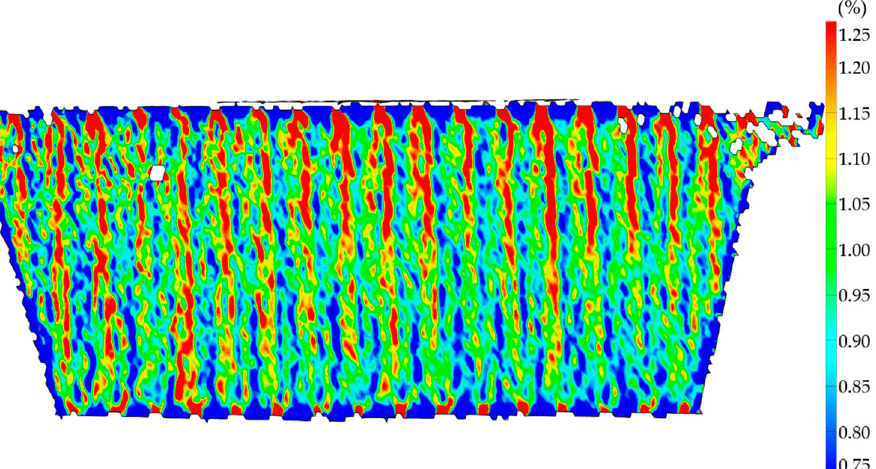
Figure 14. Specimen N19 tested along Y with high fiber misalignment in DIC at 1% average strain along 25 mm of center line.